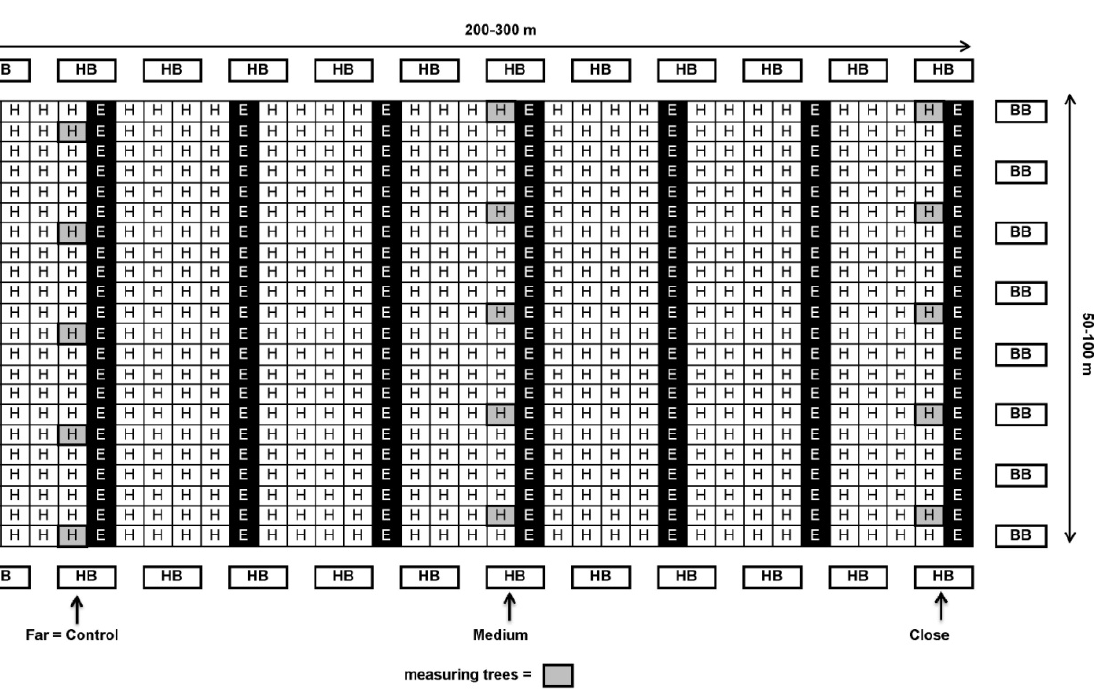
Figure 1. Schematic design of ‘Ettinger’ and ‘Hass’ plot at a 1:4 ratio (Kfar Giladi and Regba) with honeybee (HB) hives at the beginning and end of the rows and bumblebee (BB) hives on only one side of the orchard (right) or on both sides (not shown on the map). Close: 30–100 m; medium: 100–200 m; far: 200–300 m from BB hives.